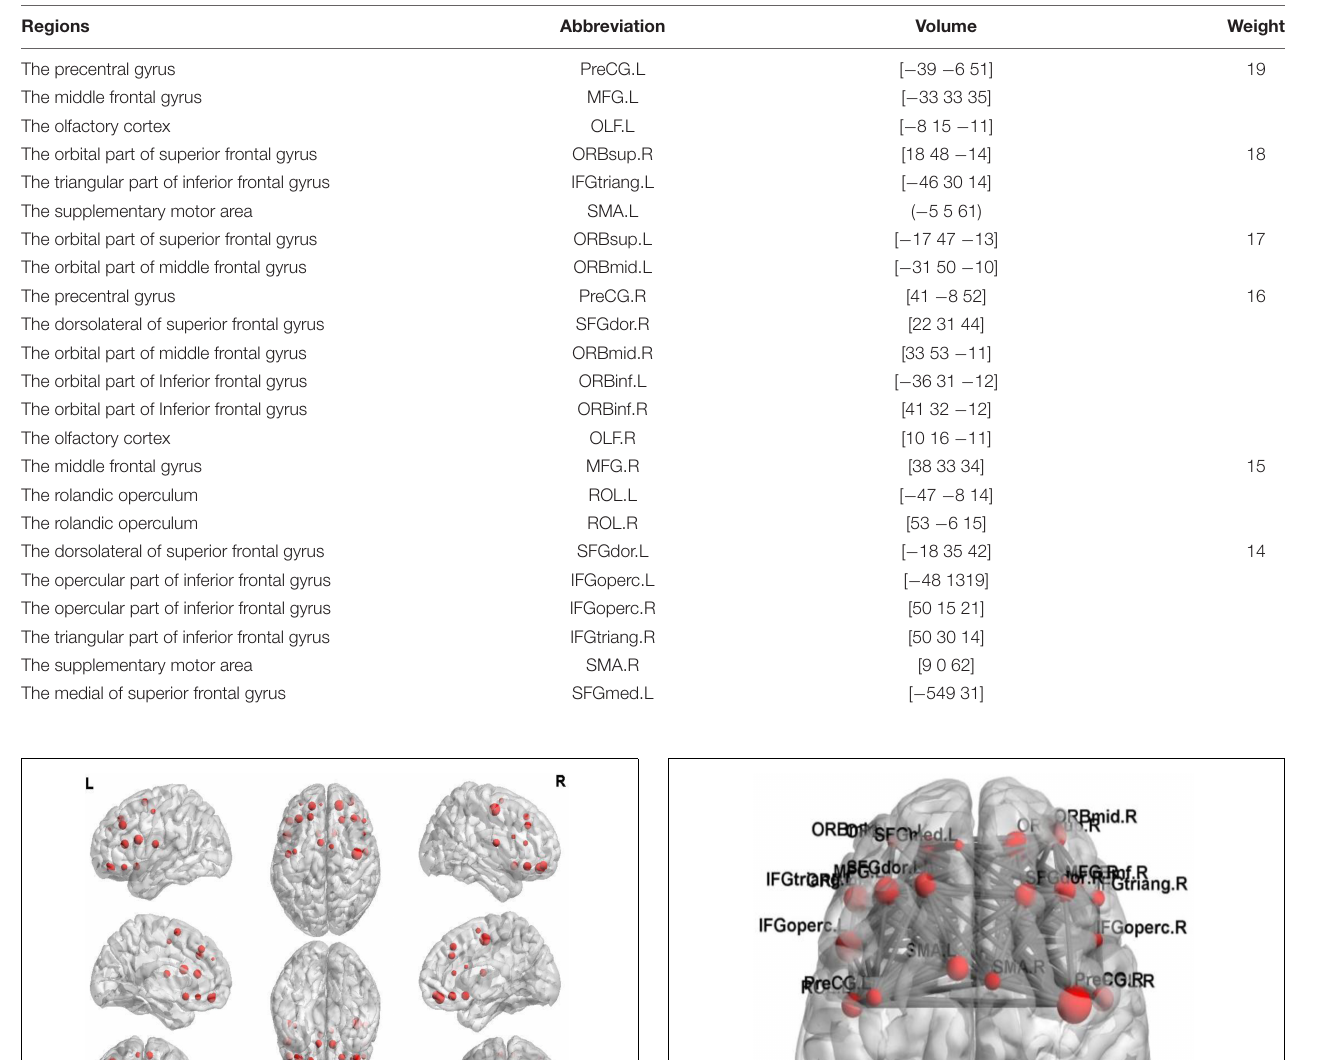
TABLE 3 | Abnormal brain regions.